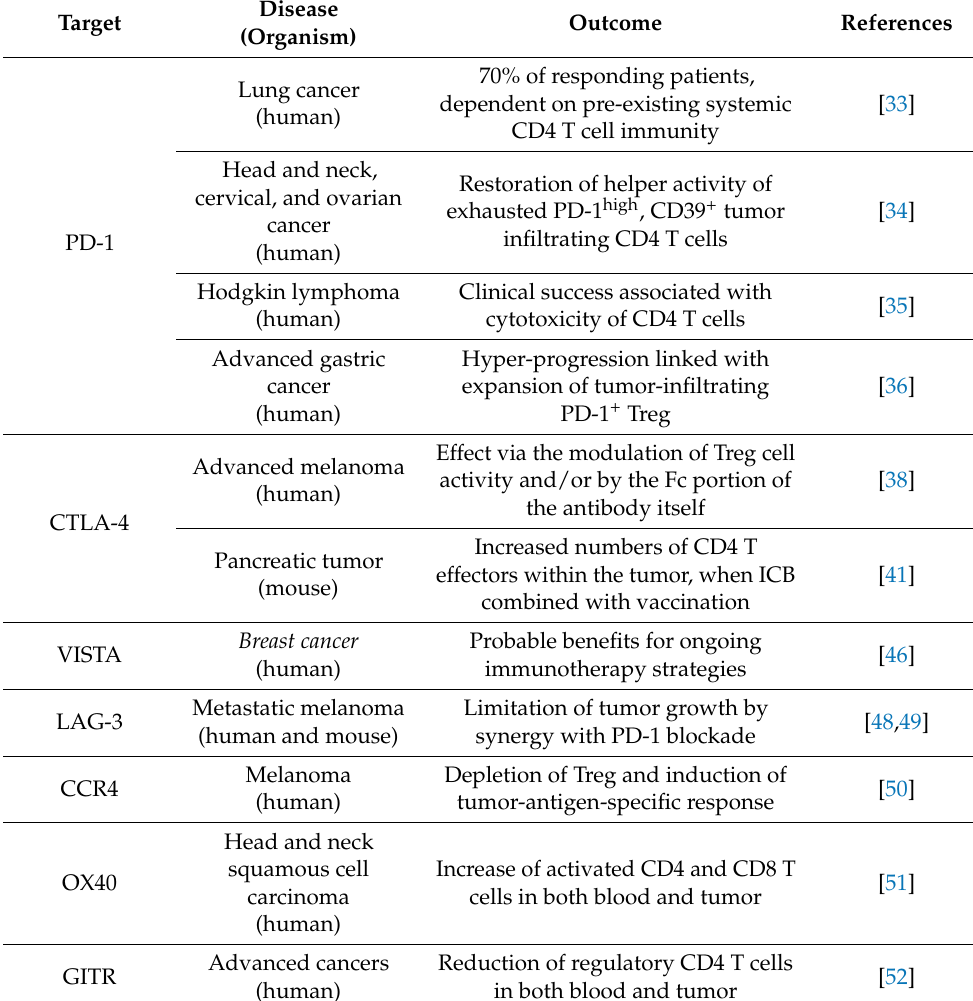
Table 1. Summarizing table on CD4 T cell involvement in ICB